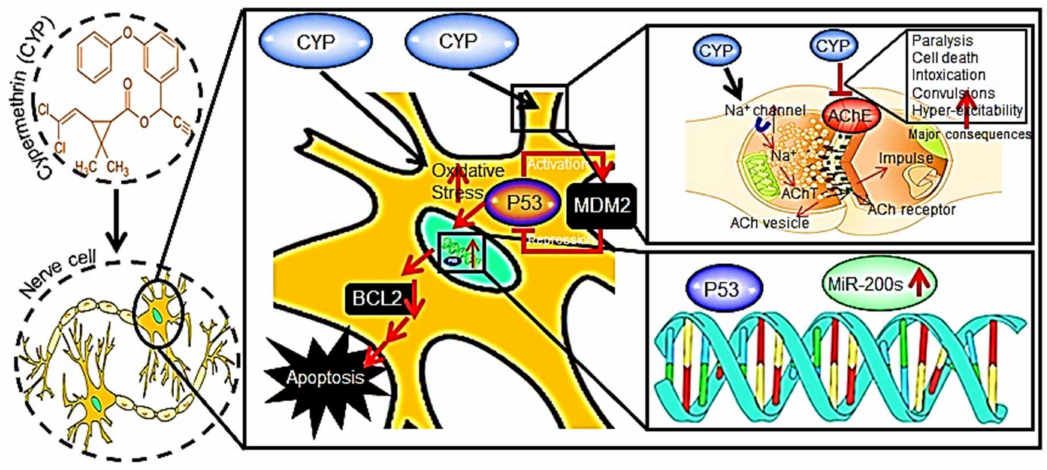
Figure 3. The neurotoxicity and other major consequences of CYP (Reproduced from Ref. [21] with permission from